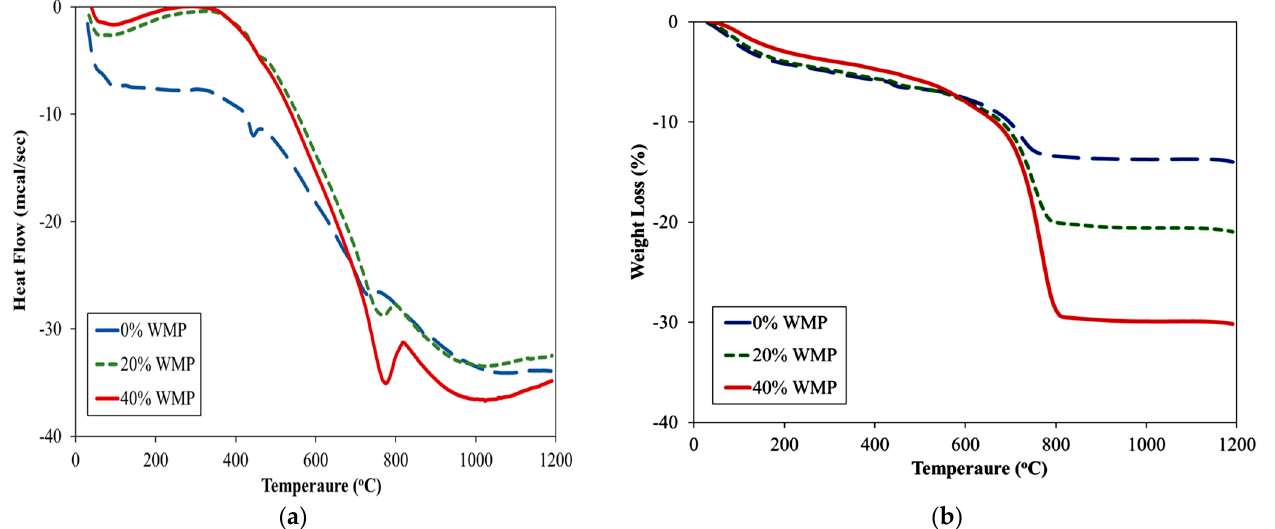
Figure 8. Thermal analysis results of Samples incorporating various dosages of MS ( a ) heatflow and ( b ) weight loss.